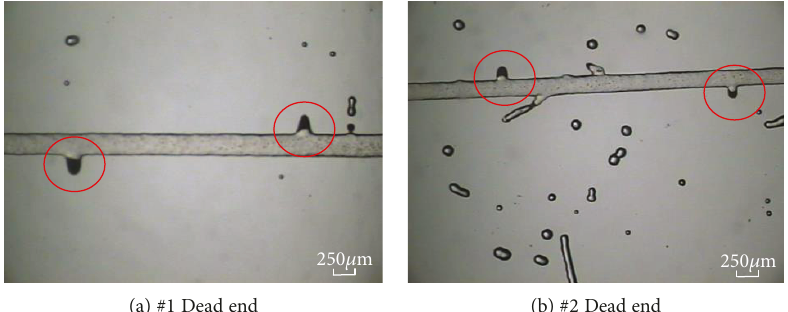
Figure 4: Distribution characteristics of residual oil at dead ends after viscoelastic polymer fl ooding (the dark area represents oil, and the lighter the color is, the lower the saturation is).